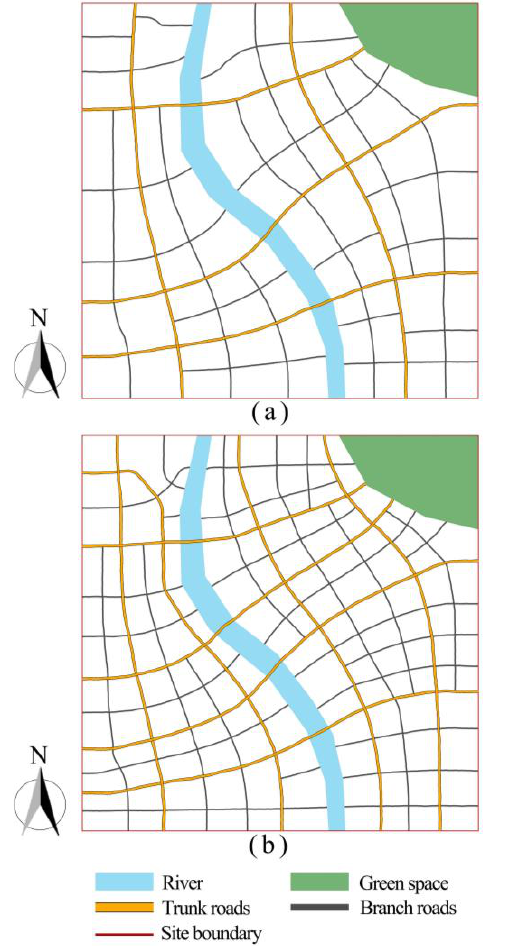
Figure 8. The results of road networks